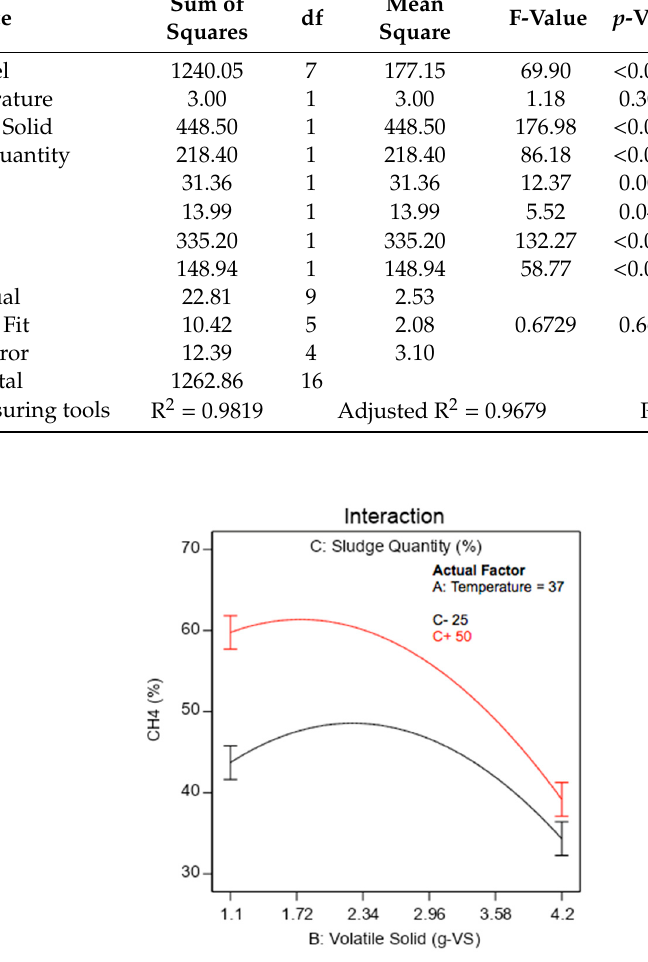
Figure 10. Interaction plot clarifying the effect of interaction between volatile solid and sludge quantity on CH 4 %.